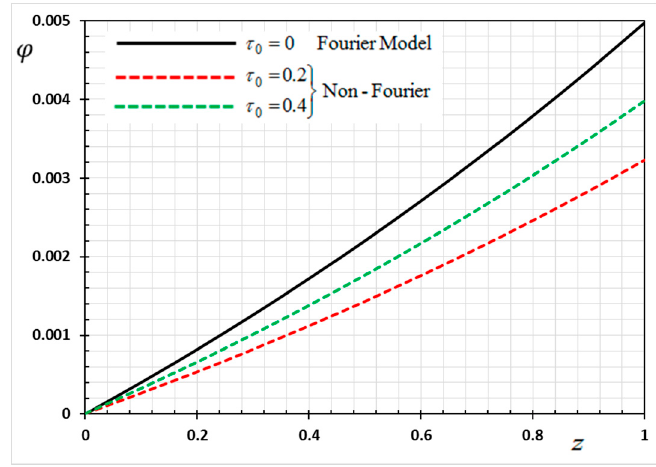
Figure 19 . Variation of thermal stress σ _zz versus z for Fourier and non-Fourier models. Materials 2020 , 13 , x FOR PEER REVIEW